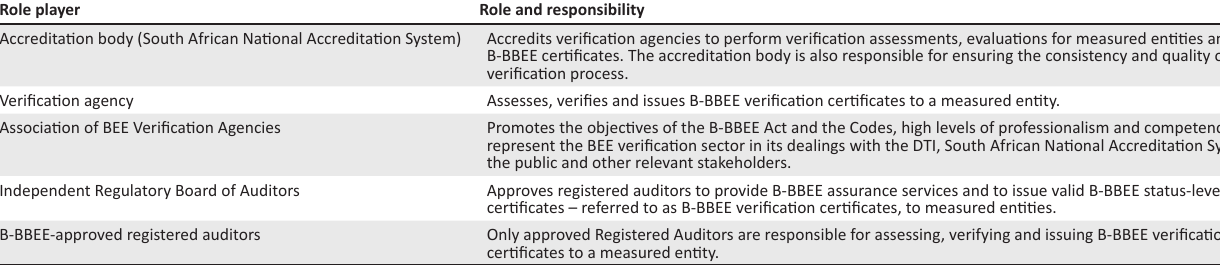
TABLE 1: Key role players in the verification process. Role